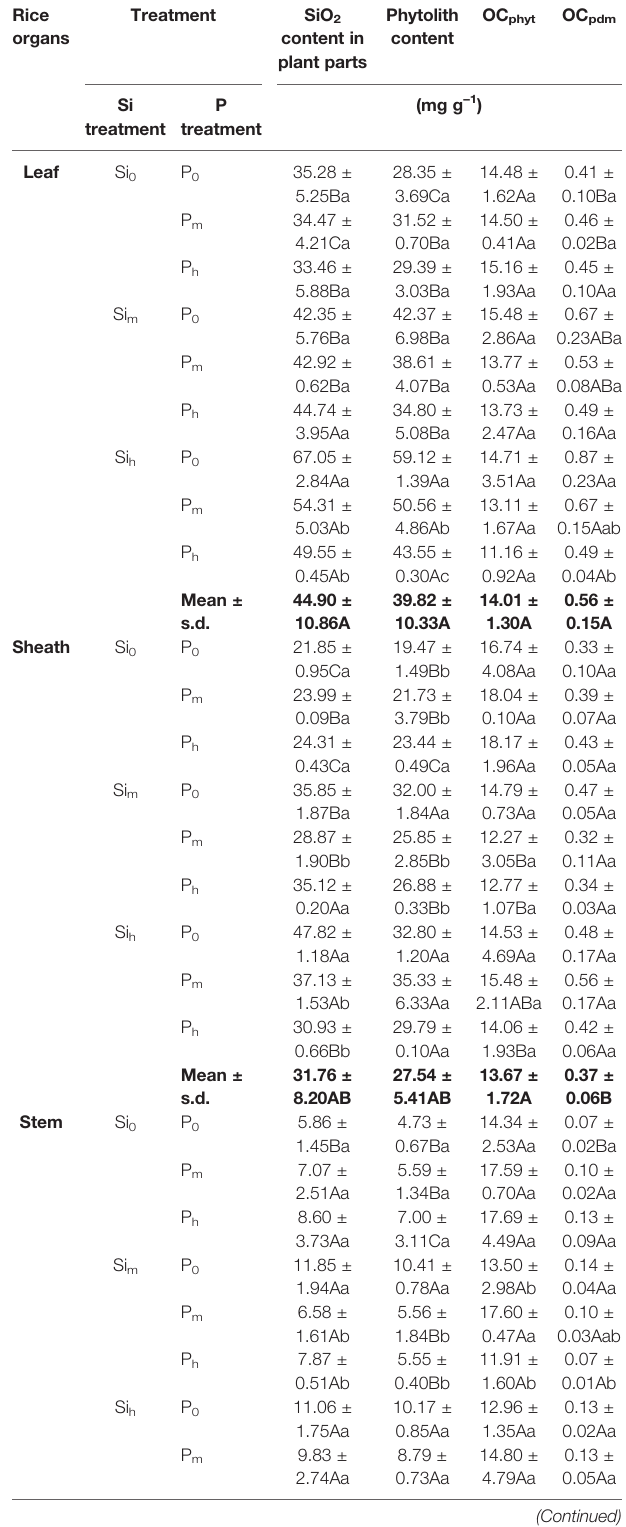
TABLE 4 | Contents of SiO 2 , phytolith, organic carbon (OC) associated with phytolith as expressed per unit mass of phytolith (OC phyt ) and of plant dry matter (OC pdm ) in different plant parts (leaf, fl ag leaf, sheath, and stem). Rice